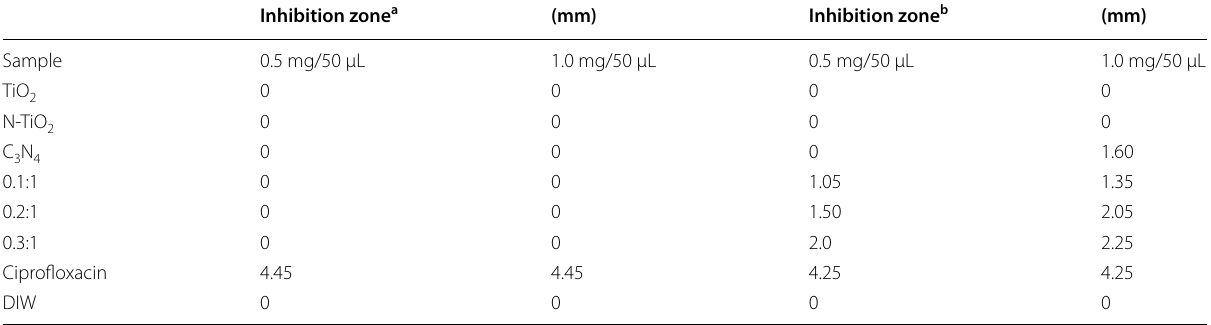
Table 1 a Inhibition zone (mm) of binary‑doped TiO for Escherichia coli